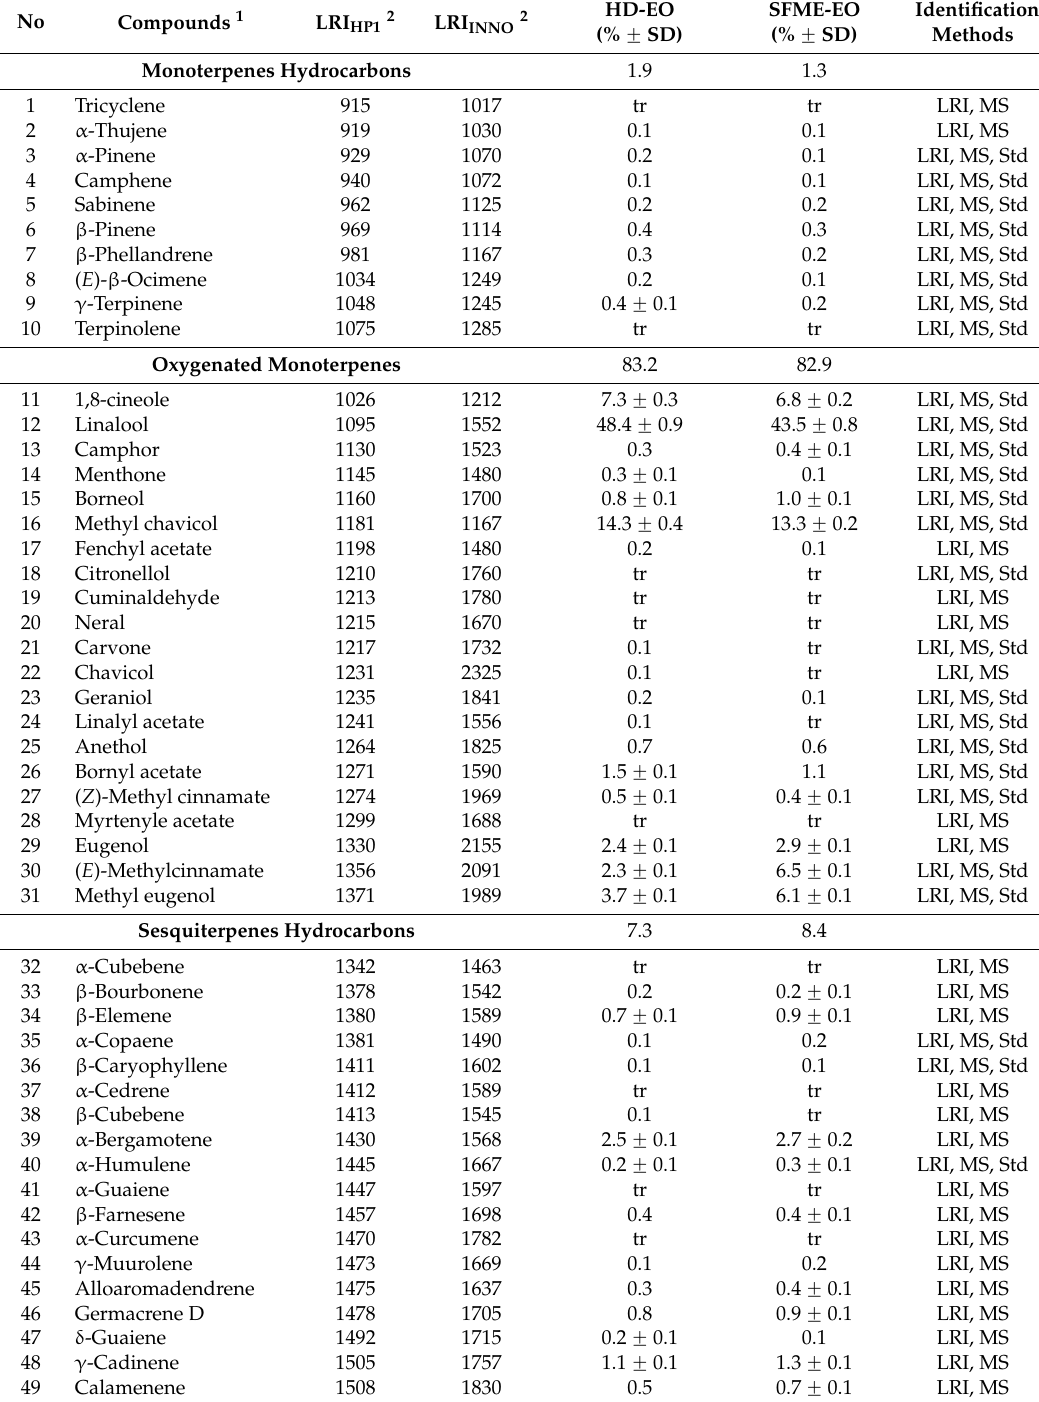
Table 2. Chemical composition of the Egyptian basil essential oils leaves obtained by SFME and